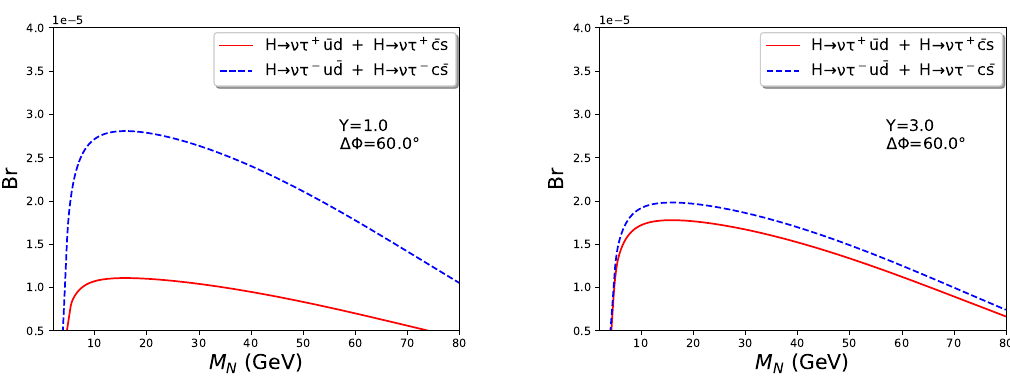
Figure 7 . Higgs boson Branching ratio as a function of HSN mass for differents values of y and ∆ φ = 60 o . Here we used | U τN | 2 = 10 − 5 , L = 1 m and A ( k )